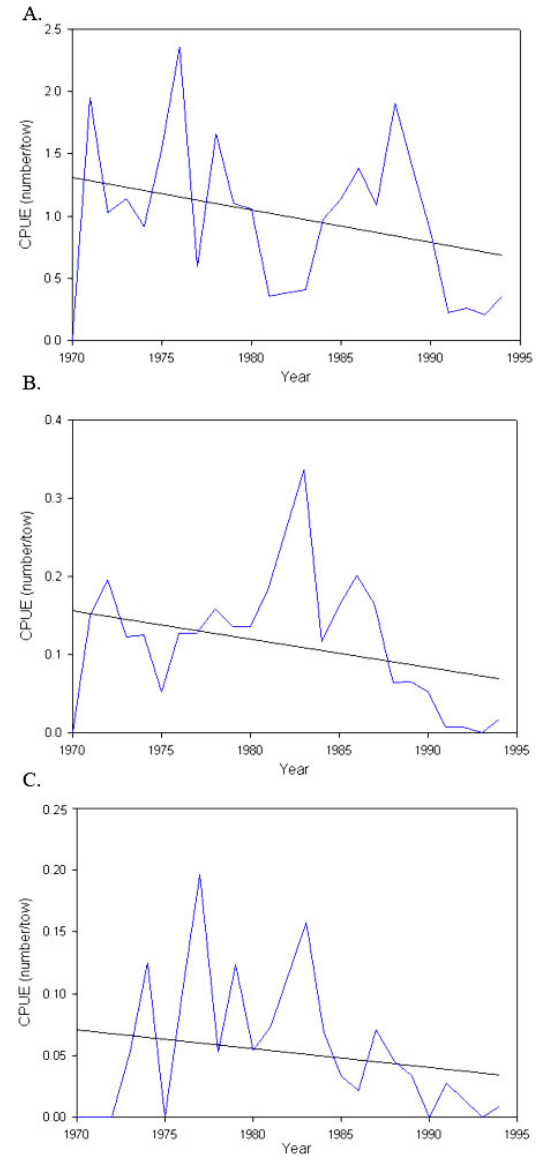
Fig. 5 . Catch per unit effort (CUPE) from the East Coast of North America Strategic Assessment Project data for Northwest Atlantic Fisheries Organization division 4R from 1970 to 1994 for (a) Anarhichas